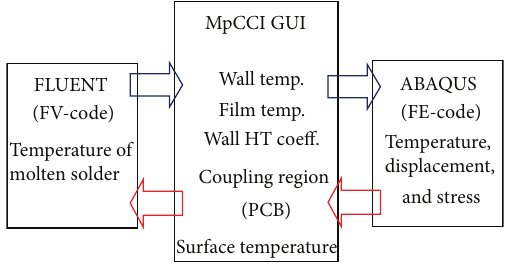
Figure 2: Basic concept of thermal-FSI coupling method.